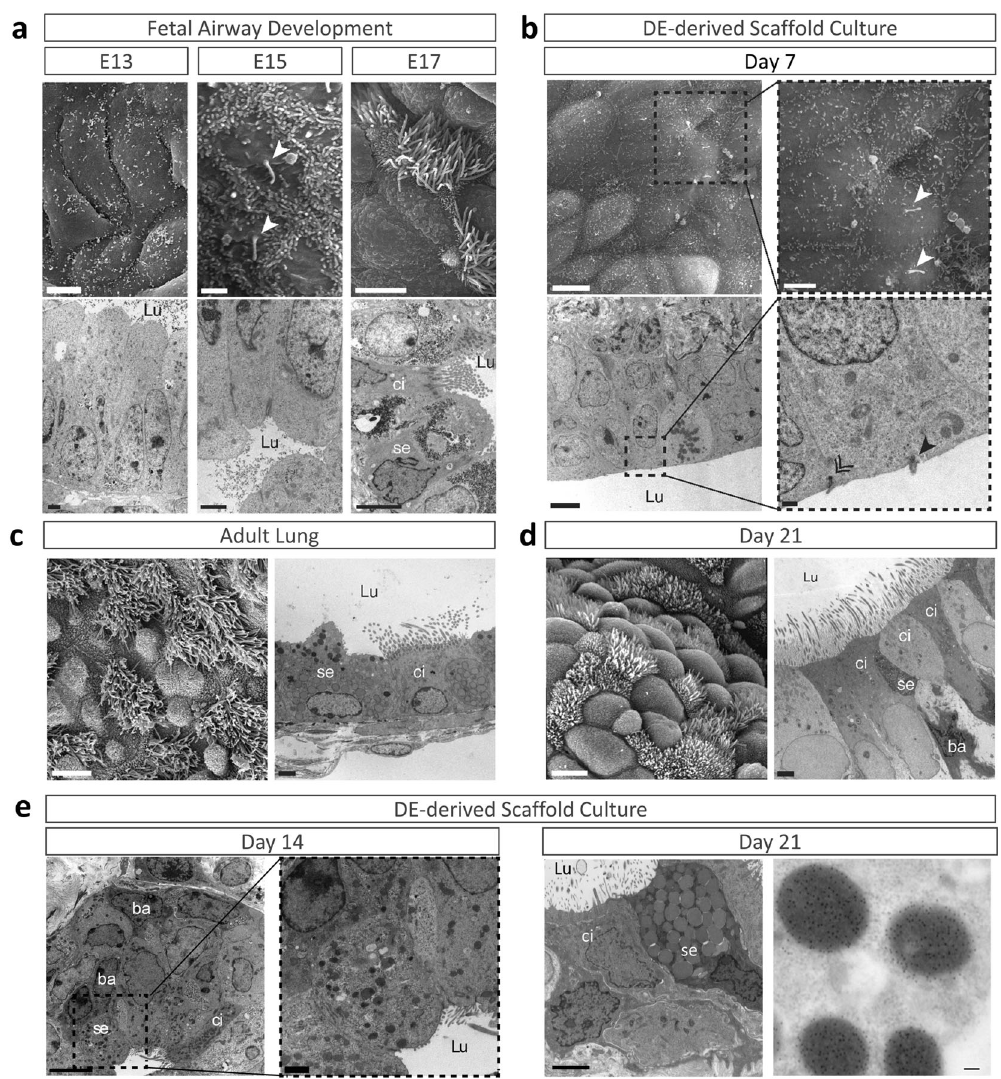
Fig. 1 Differentiation of de fi nitive endoderm (DE) cells on decellularized lung scaffolds resembles in situ epithelial differentiation of native mouse airways. a Progression of airway development in murine lung visualized by SEM (top panel) and TEM (bottom panel). b Electron micrographs of DE-scaffolds at day 7 of culture. c Electron micrographs of adult native airway epithelia. d Electron micrographs of DE-scaffolds at day 21 of culture. e- left panel Electron micrographs and immuno-TEM of DE-scaffolds at days 14 of culture. e -right-panel Immunogold labelling for SCGB1A1 of club cells at day 21. SEM, scanning electron microscopy; TEM, transmission electron microscopy; Lu, lumen; ci, ciliated cell; se, secretory cell; ba, basal cell. Scale Bars: a SEM 5 μ m, TEM 2 μ m; b SEM-left 5 μ m, TEM-left 2 μ m, SEM-right 1 μ m; TEM-right 500 nm; c , seeded with endoderm cells lacking TP63 were lined with prismatic-shaped epithelial cells having microvilli, but no cilia, and lots of debris in the lumen (Fig. 5b-right panel). These epithelial cells contained mitochondria that were larger in size (perimeter and surface area) but had a similar shape (aspect ratio and circularity) as mitochondria of epithelial cells on scaffolds seeded with wildtype endoderm cells; however, their number was signi fi cantly reduced (Supplementary Fig. 5a). Interestingly, gene expression of Foxj1 (marker for ciliated cells 36 ) and Scgb1a1 did not follow the protein expression of TUBB4A and SCGB1A1 (Fig. 5a). Expression of Foxj1 remained unchanged while that of Scgb1a1 trended higher in scaffolds seeded with TP63-de fi cient versus wildtype endoderm cells. The absence of TP63 did not shift the differentiation of DE cells on the acellular lung scaffolds from proximal toward distal airway cells. Gene expression of Nkx2.1 (lung progenitor marker 37 ) and Sox2 ( proximal lung lineage marker 38 ), respectively, was not